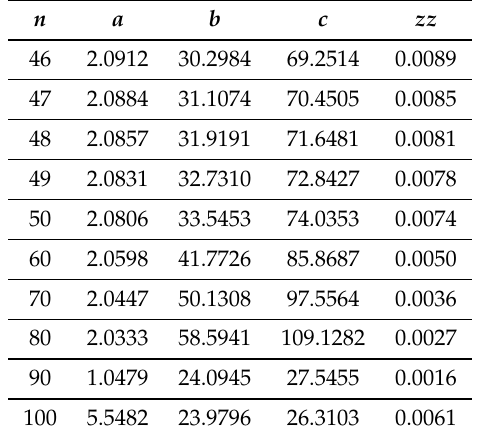
Table 6. Minimizing area point method (confidence level is